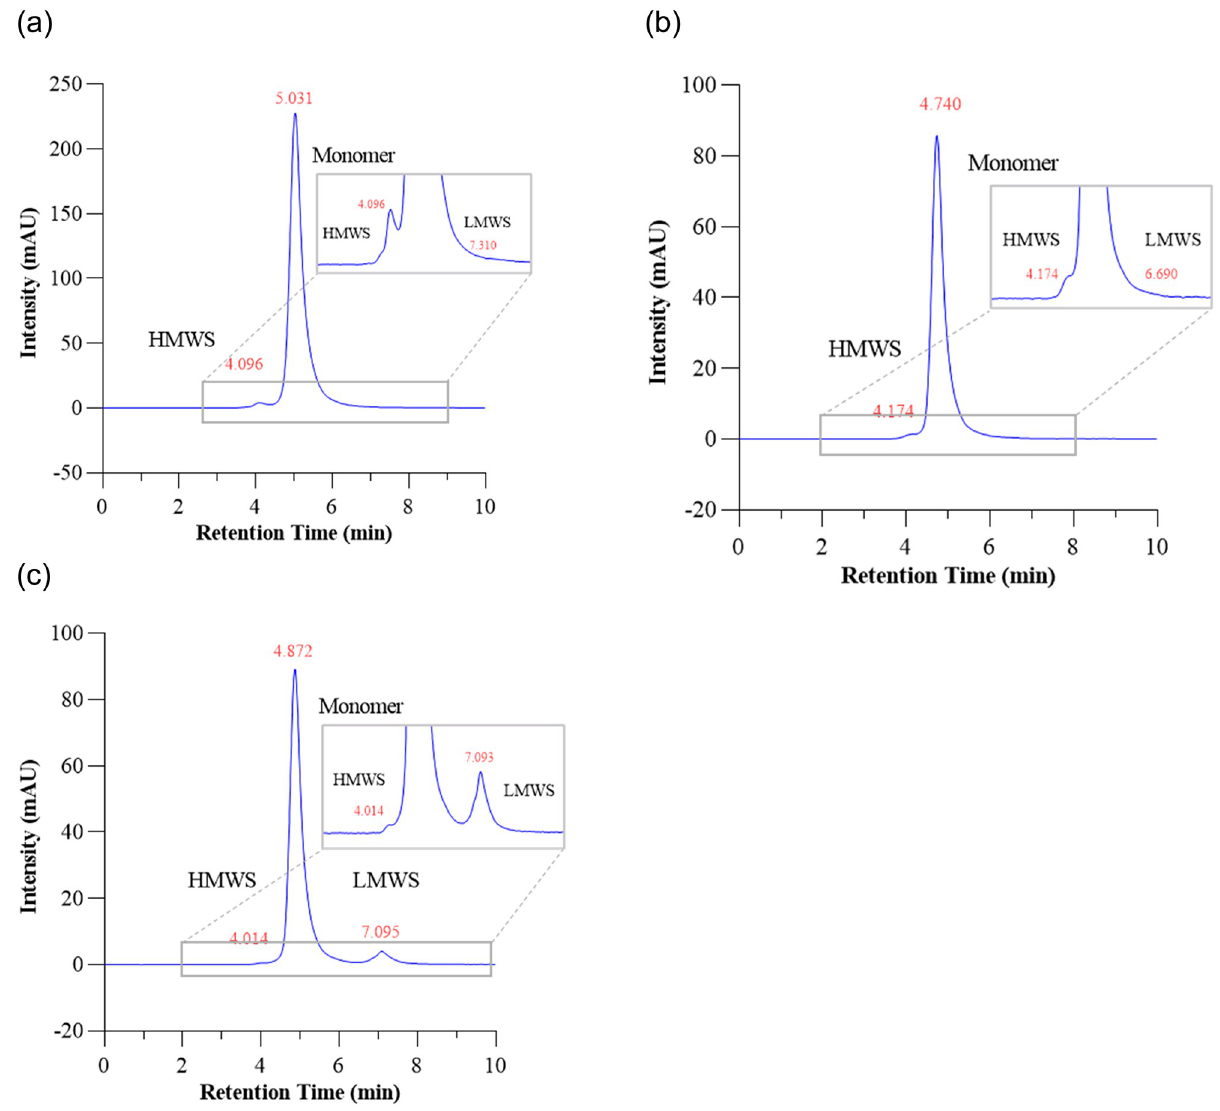
Fig 9. Elution profile of monomeric (a) Bevacizumab, (b) Trastuzumab and (c) Rituximab as received by Size Exclusion Chromatography.